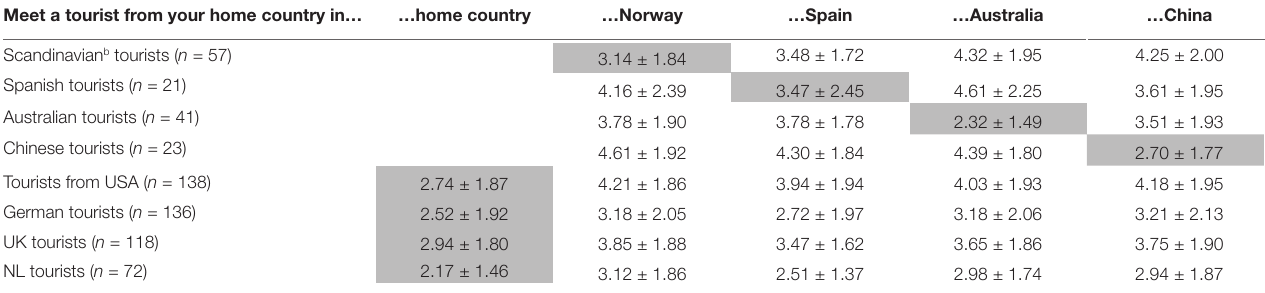
TABLE 1 | Interestingness a of meeting a tourist from one’s home country in various countries [scale: 1 (not interesting) – 7 (very interesting), mean scores, ±SD]. Meet a tourist from your home country in… …home